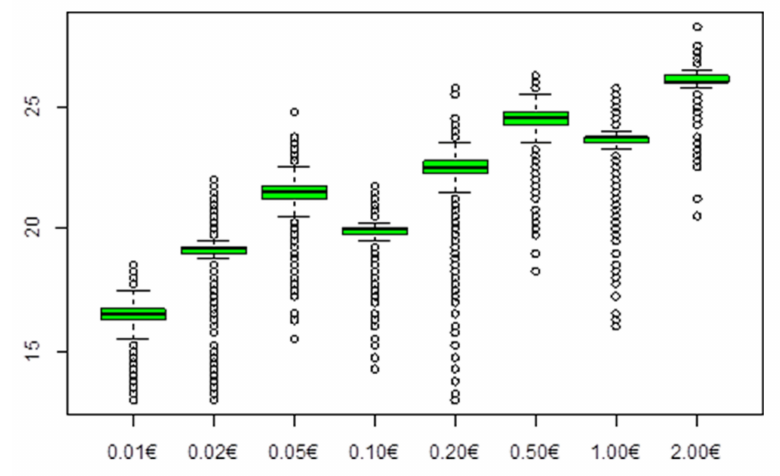
Figure 8. Box plot with the diameters of the coins. Figure 9a–d show the variation of the level of colours in red, orange, yellow and